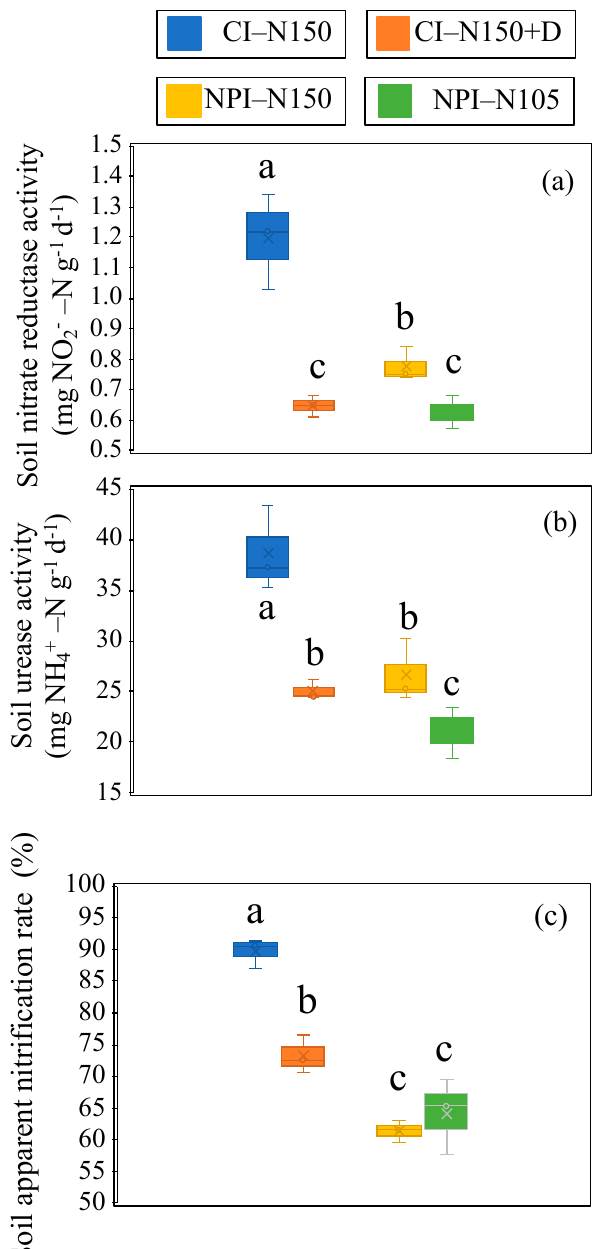
Figure 4. Soil nitrate reductase and urease activities, soil apparent nitrification rate under different irrigation and N treatments. ( a ) Soil nitrate reductase activity; ( b ) Soil urease activity; ( c ) Soil apparent nitrification rate. CI is conventional irrigation, and NPI is negative pressure irrigation. N150: 150 kg N ha − 1 , N105: 105 kg N ha − 1 ; D is DCD addition. All of the data are the means of three replicates ± SE, and different letters indicate significant differences between the treatments ( p < 0.05) by Duncan’s tests.